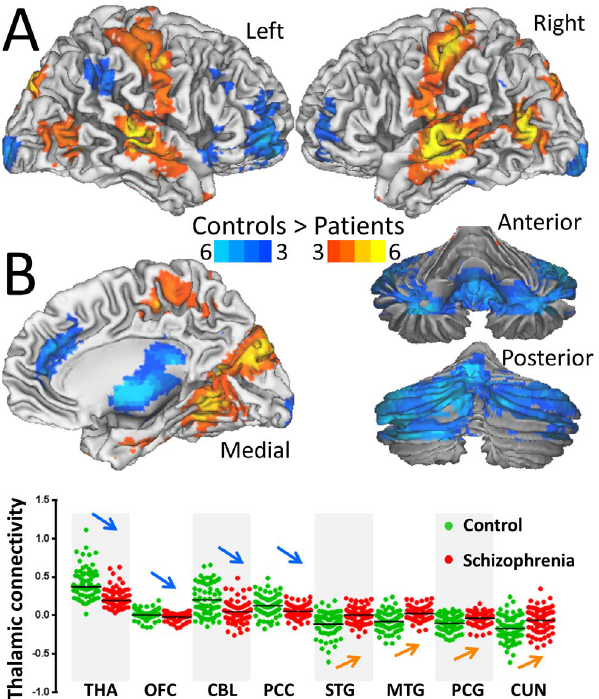
Figure 8. Reduced functional connectivity of the thalamus in schizophrenia. (A) Statistical significance (t-scores) of decreases in the positive (blue-cyan) and negative (red-yellow) FC of the thalamus in schizophrenia (N = 69) compared to healthy controls (N = 74), superimposed on lateral and medial surface views of the cerebrum and anterior and posterior surface views of the cerebellum. (B) Average ROI measures of thalamic FC across subjects for selected ROIs (0.9 mm cubes; 27 voxels) centered at the MNI coordinates listed in Table S3, showing the lower absolute FC for schizophrenia patients than for controls in thalamus (THA), orbitofrontal cortex (OFC; BA 11), posterior lobe of the cerebellum (CBL), posterior cingulum (PCC) (positive connectivity: blue arrows; P , 0.0005), and for superior and middle temporal (STG and MTG; BA 22) and postcentral (PCG; BA 3) gyri and cuneus (BA 19) (negative connectivity: orange arrows; P , 0.0005). MNI coordinates of the bilateral cubic seed (54 voxels) in the thalamus: x = 6 6 mm; y = 2 3 mm; and z = 0 mm. adolescents than for adults (P c , 0.05, Bonferroni corrected for multiple comparisons; Fig 6B). In addition, the average values in somatosensoty (BAs 1, 2 and 5) and gustatory (BA 43) areas, superior parietal (BA 7), frontopolar and rostrolateral prefrontal (BA 10) cortices ( lC , lL and l FCD), lateral parietal (BAs 39 and 40) and association visual (BA 19) cortices ( lC and lL ), rectus (BA 11) ( lC and l FCD), motor (BA 4) and premotor (BA 6) and auditory (BA 22, Heschl’s gyrus) areas ( lL ) and cerebellum (VIIb lobe; lC ) were higher for children/adolescents than for adults (P c , 0.05; Fig 6B). No anatomical region showed significant differences in small-worldness between children/adolescents and adults. Schizophrenia Patients with schizophrenia had shorter lL in thalamus, putamen, anterior insula, midbrain, middle frontal, postcentral and angular gyri and cerebellum (VIIb, VIII), and lower lC and weaker l FCD in thalamus, putamen, anterior insula, midbrain and postcentral gyrus than healthy controls (P FWE , 0.05; Fig 7A and Table 3). On the other hand, differences in small-worldness between patients and controls were not statistically significant for